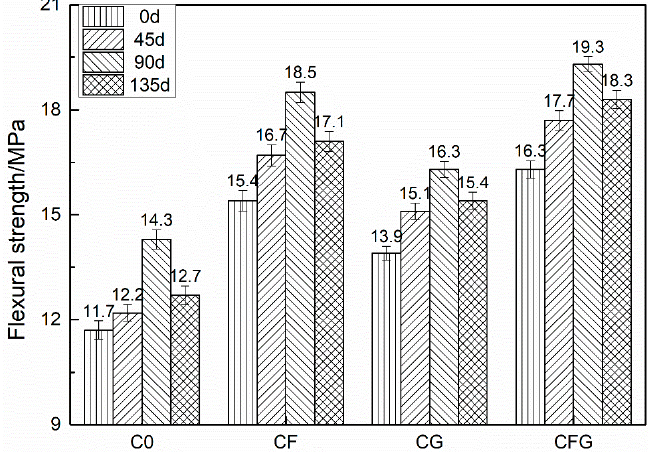
Figure 6. Flexural strength of samples under the sulfate corrosion condition.